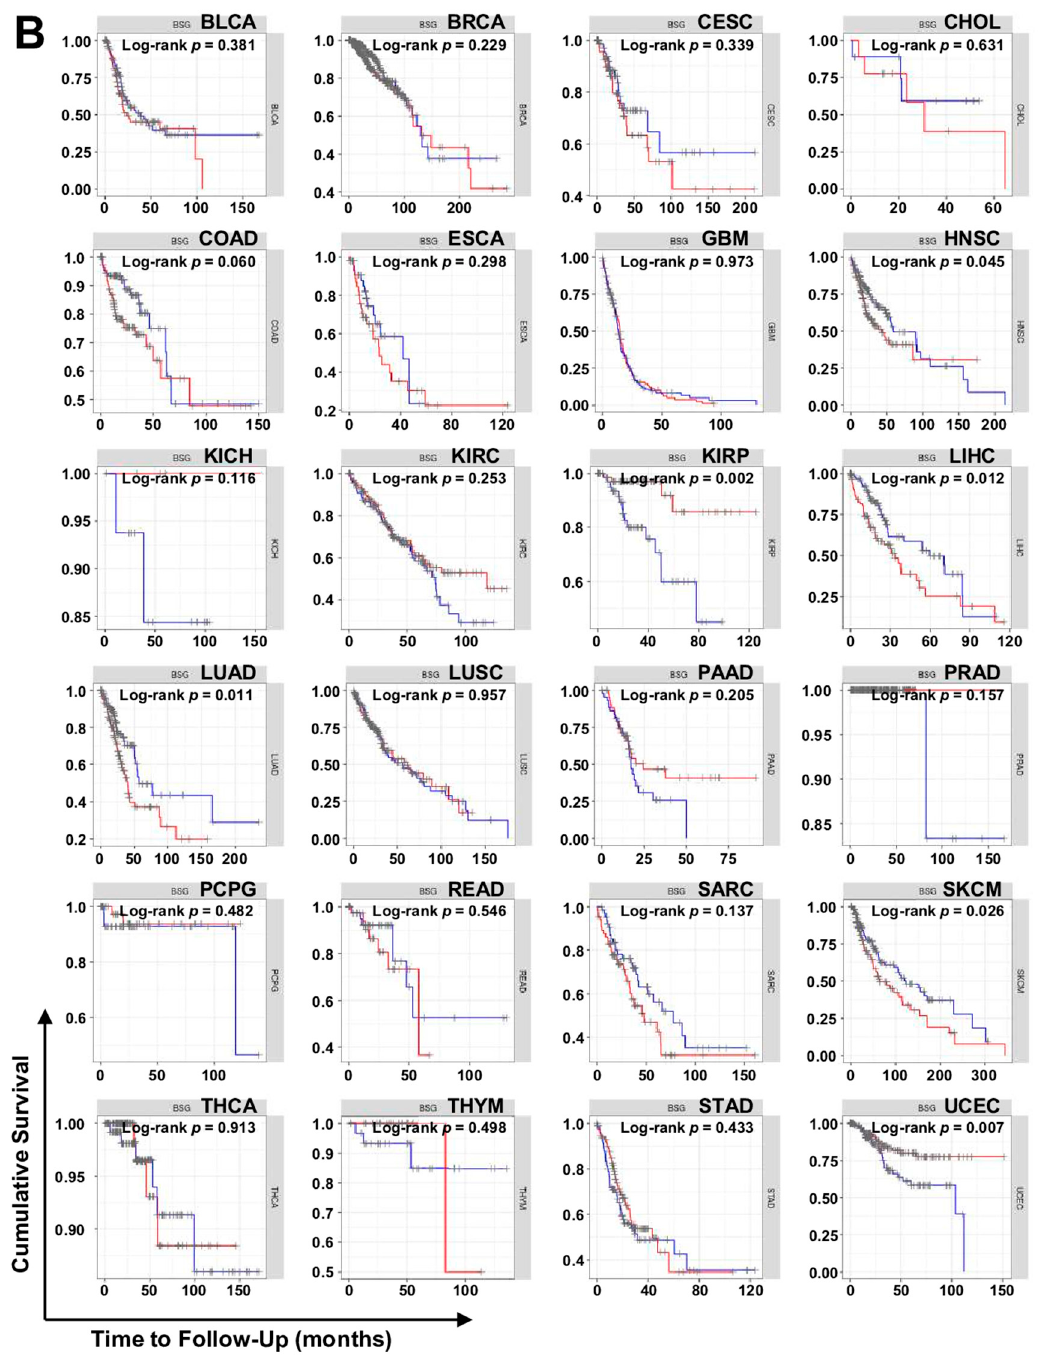
Figure 7. Correlation of PPIA and BSG expression on patient survival. ( A ) Relationship of PPIA mRNA expression. ( B ) Relationship of BSG mRNA expression. The data were obtained through TIMER analysis using the TCGA database. The full name of each carcinoma is described in the legend in Figure 5. Red line, high (top 25% expression group); blue line, low (bottom 25% expression group).